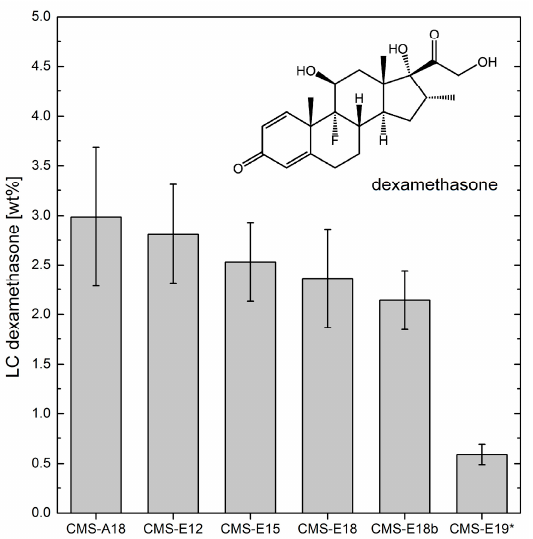
Figure 3. Loading capacities of the investigated carrier systems. Encapsulation was performed with the film uptake method, n = 3, * performed at 60 °C.